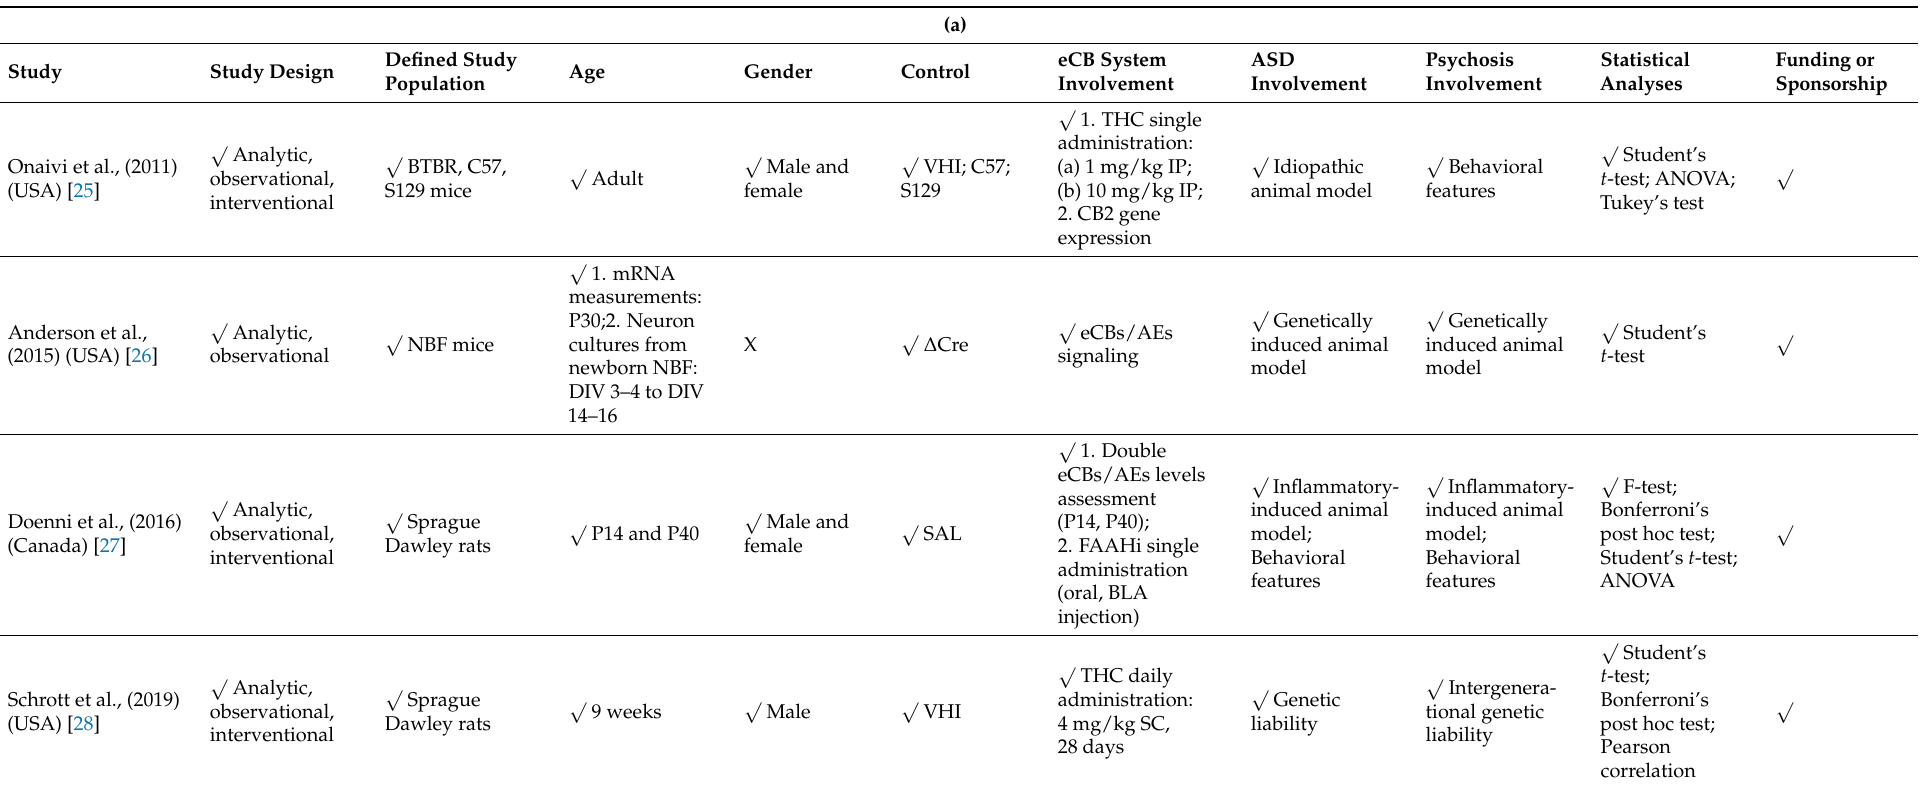
Table 2. ( a ). Methodological quality of animal studies investigating ASD and psychosis as a function of the eCB system. ( b ). Methodological quality of human studies investigating ASD and psychosis as a function of the eCB